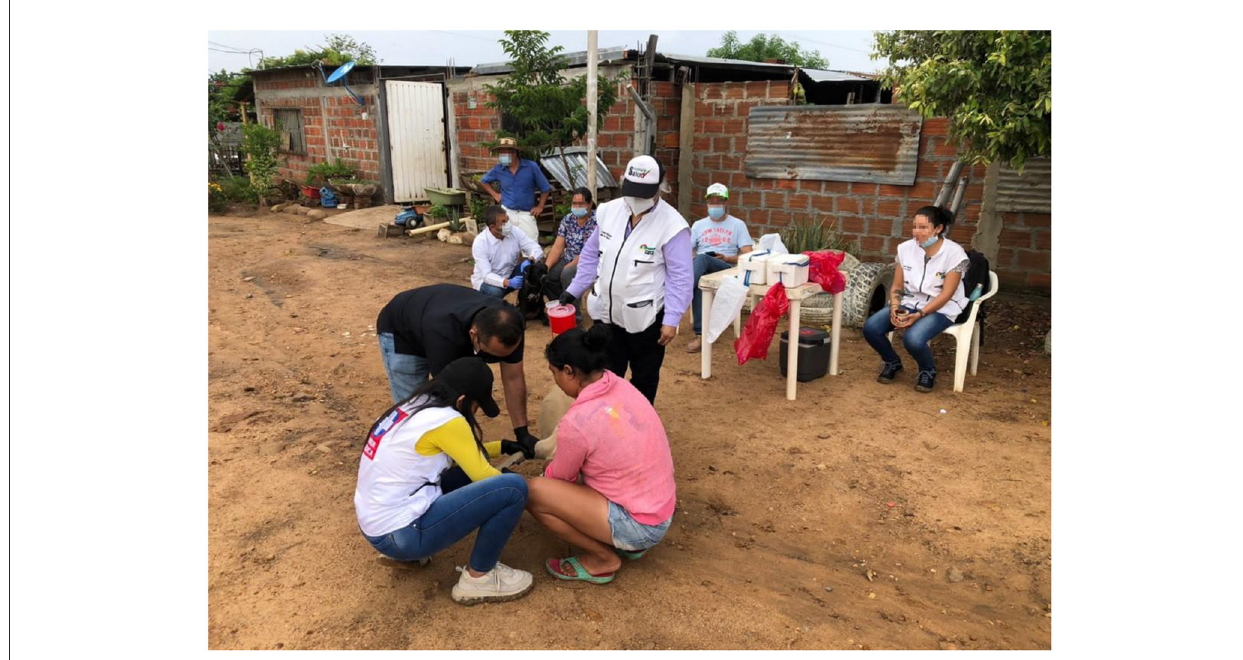
FIGURE2 Researchers, public health staff, and local community participating at dogs’